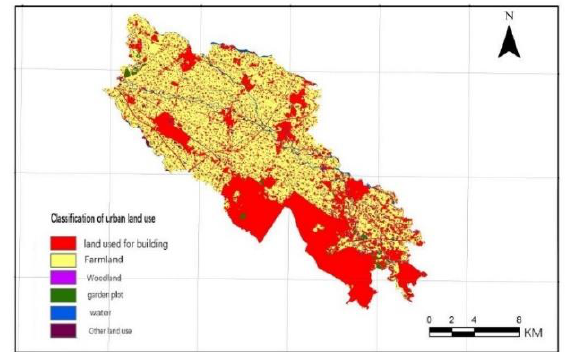
Figure 8 Forecast of Urban Land Use in 2019